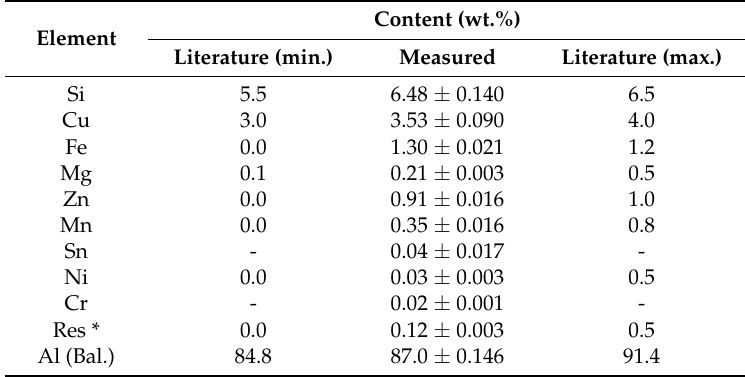
Table 1. Chemical composition of the B319+Fe alloy studied here as measured by OES and the expected range (min-max) for a conventional B319 alloy in the literature